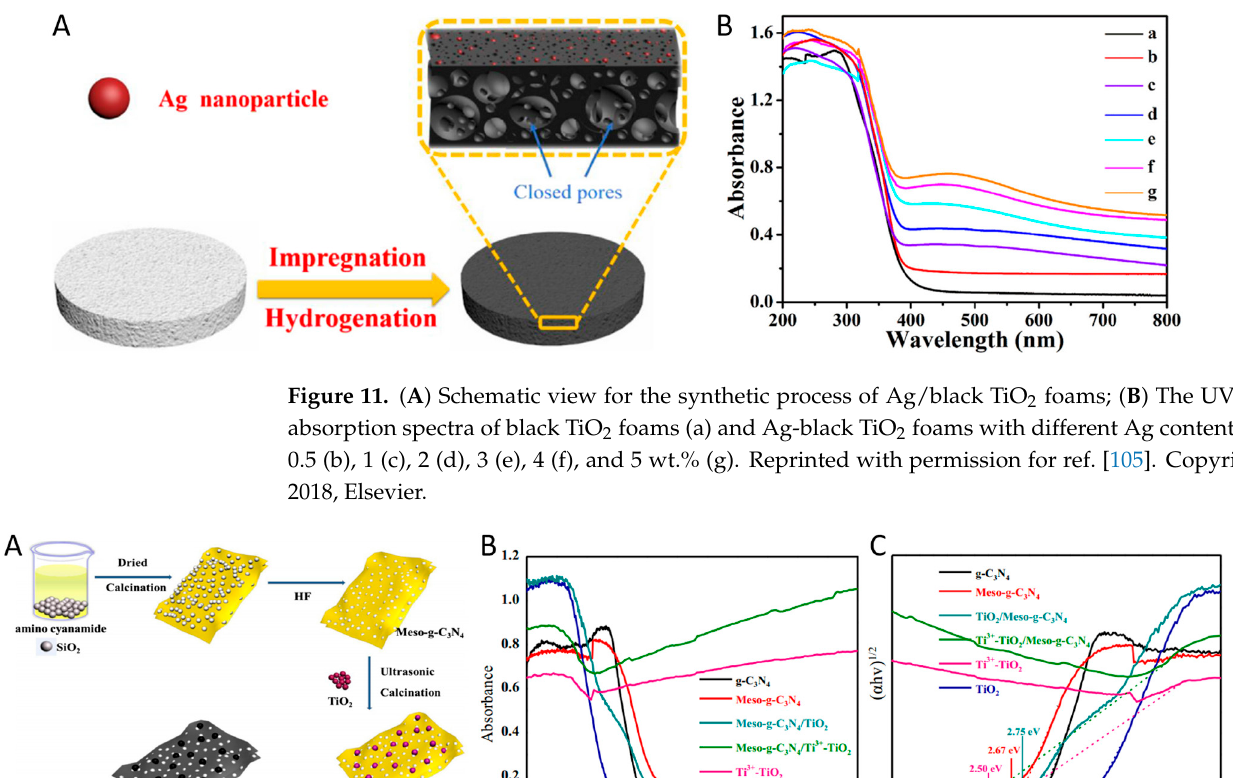
16 of 28 Figure 10. Schematic illustration for preparation of 3D urchinlike Ag/N-TiO 2 − x . Reprinted with per- mission for ref. [104]. Copyright 2018, Elsevier. Li et al. constructed Ag nanoparticle-decorated black TiO 2 foams through the wet impregnation and high temperature surface hydrogenation process [105]. Ag nanoparti- cles were formed in the open pores of black TiO 2 foams after the hydrogen atmosphere reduction, thus decreasing its surface area [105]. The synthetic process and UV-vis absorp- tion spectra of Ag-black TiO 2 foams were presented in Figure 11 [105]. The Ag-black TiO 2 foams with varied amounts of silver showed apparent absorption at around 500 nm thanks to the SPR effect of Ag nanoparticles [105]. The Ag-black TiO 2 foams containing 3 wt.% Ag nanoparticles exhibit the highest photocatalytic efficiency for atrazine removal [105]. Excess amounts of Ag nanoparticles in black TiO 2 foams would decrease its photo- catalytic performance due to the aggregation of Ag nanoparticles [105]. Ag nanoparticles were also decorated onto black TiO 2 nanorods [106,109] and nanotubes surface [38], to